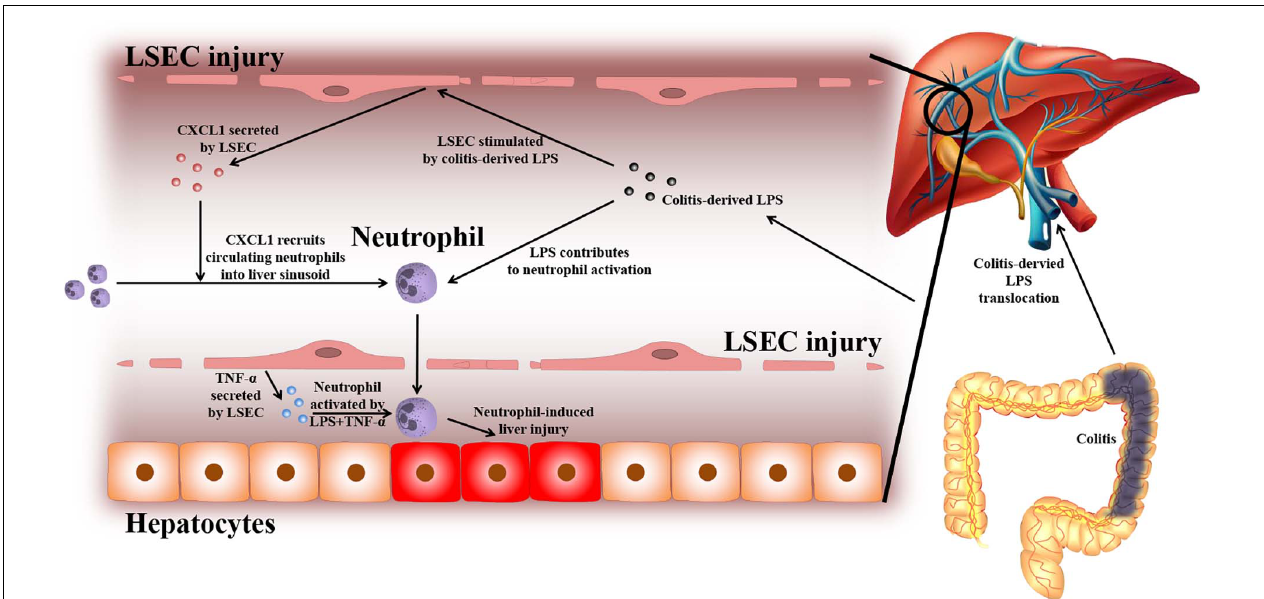
FIGURE 8 | Proposed mechanism of LSEC barrier in the gut–liver axis. A leaky gut can lead to the translocation of gut-derived pathogenic factors [e.g., lipopolysaccharide (LPS)] to the portal vein and encounter liver sinusoidal endothelial cells (LSECs). Under normal conditions, the intact LSEC barrier can defend against these invasive factors. When LSECs are damaged, they can shift toward a pro-inflammatory phenotype. Under the stimulation of gut-derived LPS, damaged LSECs can secrete pro-inflammatory mediators including neutrophil-chemoattractant CXCL1 and TNF- α . CXCL1 induces the recruitment of peripheral blood neutrophils into the liver. Neutrophils are further activated by gut-derived LPS and LSEC-derived TNF- α . Activated neutrophils can produce massive reactive oxygen species (ROS), pro-inflammatory cytokines, and neutrophil extracellular traps (NETs), which lead to enhanced liver